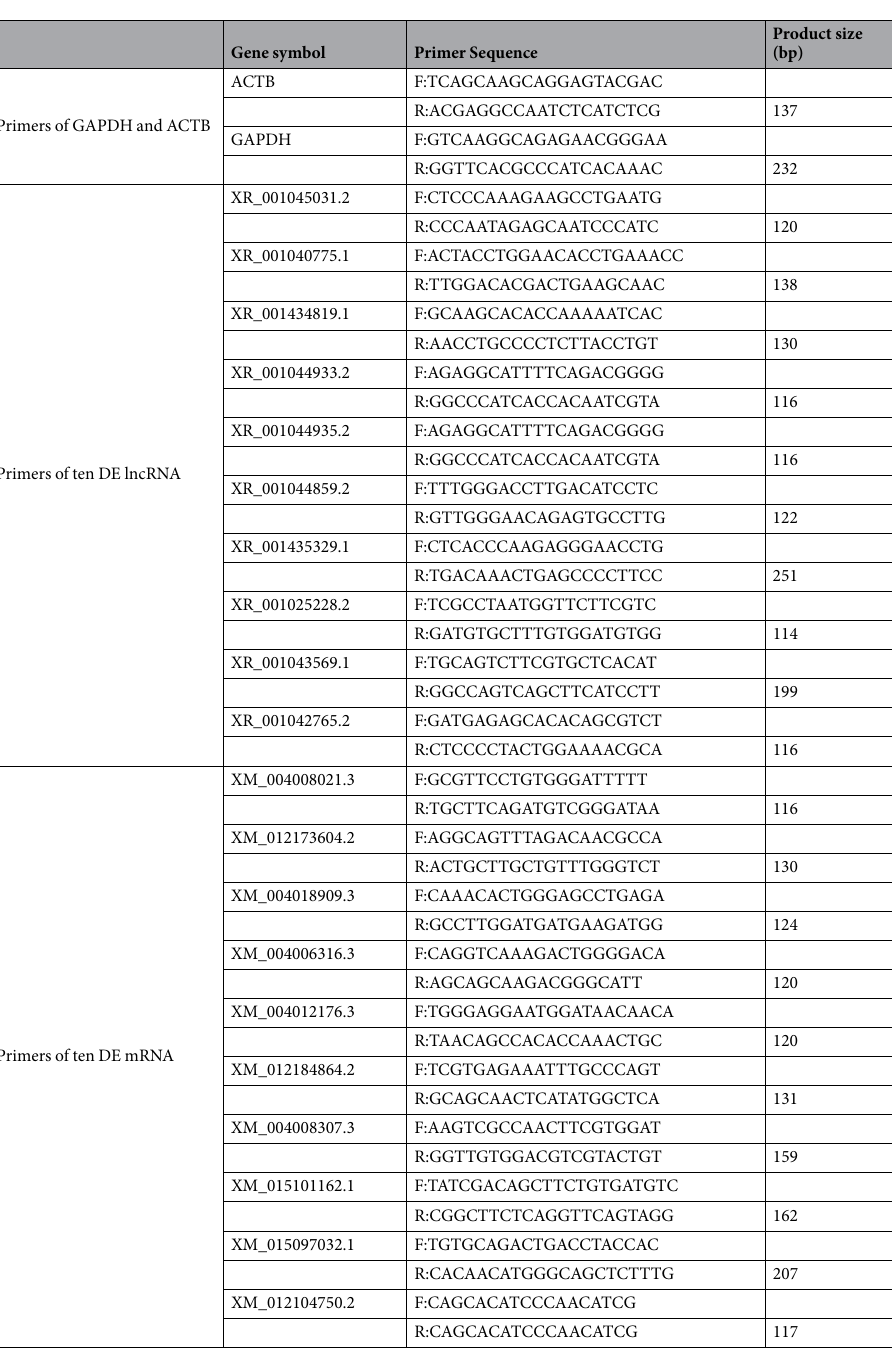
Table 4. The primer of GAPDH, ACTB, DE lncRNAs and